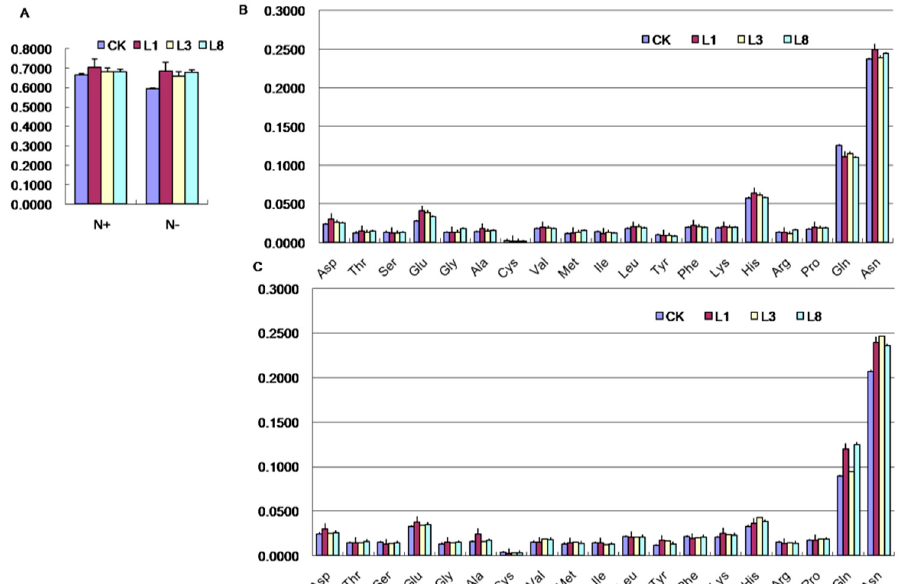
Figure 7. Concentrations of amino acids in transgenic and wild-type plants: ( A ) Concentrations of total amino acids; ( B ) Amino acid analysis at the normal N level; ( C ) Amino acid analysis at the low N level. L1, L3 and L8 were transgenic lines. CK was wild-type control line. Arabidopsis thaliana seedlings were treated with normal nitrogen (N+) and low nitrogen (N − ). Data represent the mean value ± S.E. of three replicates.